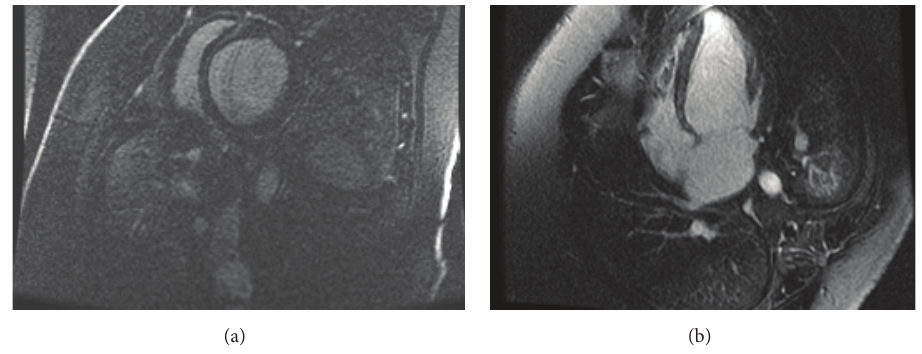
Figure 1: Short axis (a) and four-chamber (b) delayed hyperenhancement images demonstrate midwall septal enhancement of the left ventricle, suggestive of myocarditis in this clinical